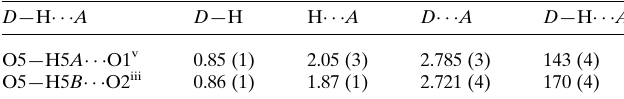
Table 2 Hydrogen-bond geometry (A˚ , (cid:4)